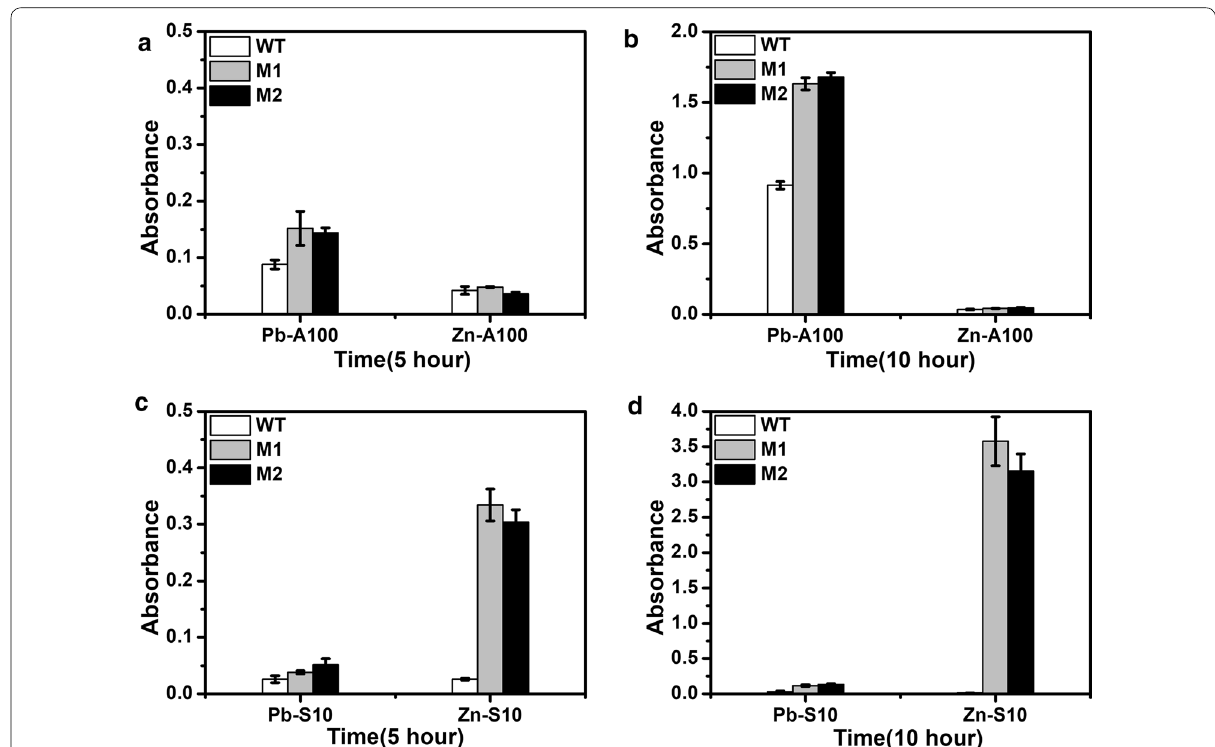
Fig. 6 Characterization of the growth of the mutants in response to lead and zinc under the ON condition with ampicillin for a 5 h and b 10 h, under the OFF condition with sucrose for c 5 h and d 10 h. White bar: Wild type; Grey bar: Mutant M1; Black bar: Mutant M2. Culture conditions are indicated as follows: Pb—lead; A100—ampicillin; Zn—zinc; S10—sucrose. Both lead and zinc were used at 50 µM. Ampicillin was used